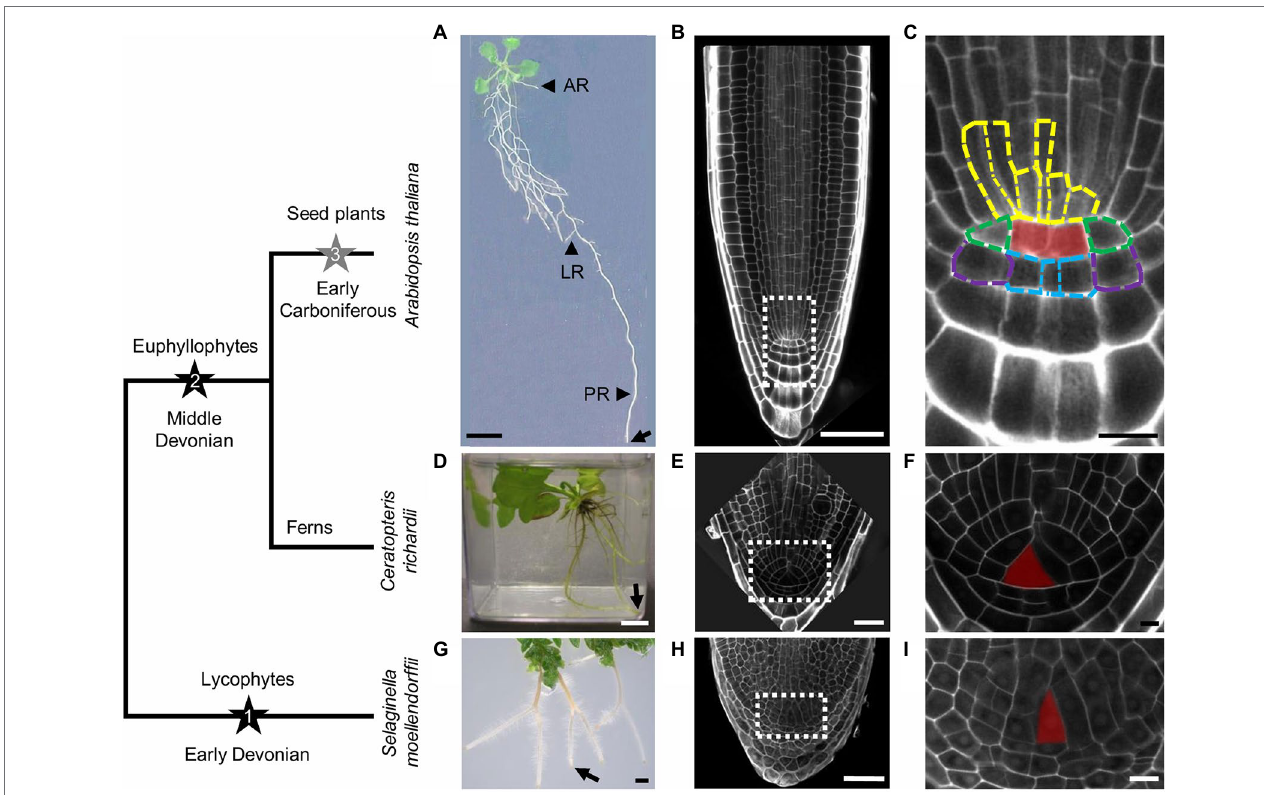
FIGURE 1 | Simplified cladogram with images of rooting system and root meristem of the major groups of vascular plants. Black stars indicate the first two (1 and 2) valid independent root origins. It is currently unclear whether root evolution in seed plants can be seen as the third independent event (3), indicated by a gray star. (A,D,G) Rooting systems of Arabidopsis thaliana (A) , Ceratopteris richardii (D) , and Selaginella moellendorffii (G) . (A) In A. thaliana , adventitious roots (AR) and lateral roots (LR) arise from hypocotyl and primary root (PR), respectively. (B,E,H) Root meristems of A. thaliana (B) , C. richardii (E) , and S. moellendorffii (H) , which are magnifications of the root tips indicated by the arrows in (A,D,G) . (C,F,I) are magnifications as indicated by the dashed rectangles in (B,E,H) . (C) The quiescent center (red overlay) regulates or organizes the surrounding stem cells (initials) indicated by dashed outlines in different colors: vasculature initials (yellow), columella initials (blue), lateral root cap/epidermis initials (purple), and endodermis/cortex initials (green). In C. richardii (F) and S. moellendorffii (I) , the central apical cell or initial cell (red overlay) presumably organizes itself and is the sole root stem cell. Scale bars: 1 cm (A,D,G) , 50 μ m (B,E,H) , and 10 μ m (C,F,I)